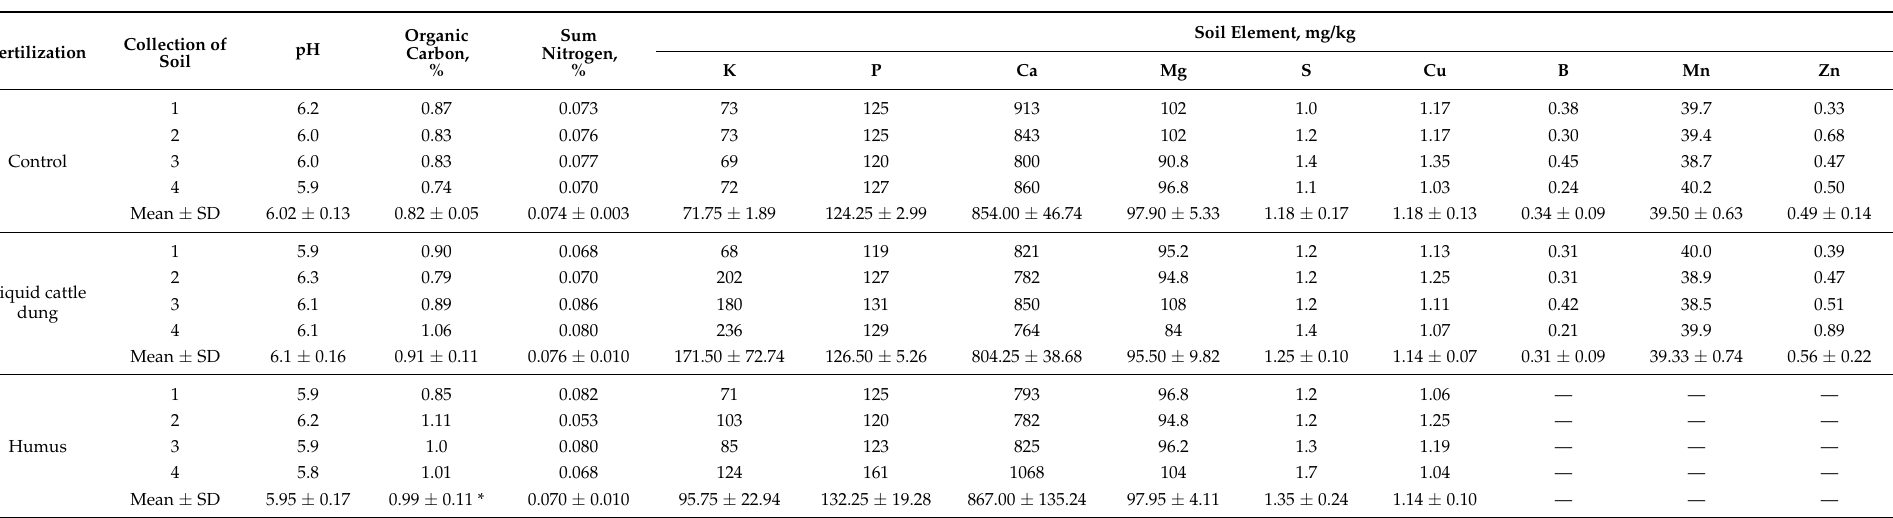
Table 2. Changes in soil pH and chemical composition during fertilization with liquid cattle dung and humus in the first experimental year. 1 denotes soil collection before the first fertilization with liquid cattle dung and humus; 2 denotes soil collection before the second fertilization with liquid cattle dung and humus; 3 denotes soil collection before the third fertilization with liquid cattle dung and humus; 4 denotes soil collection before the collection of plant raw material; SD—standard deviation; line (—) denotes unanalyzed soil